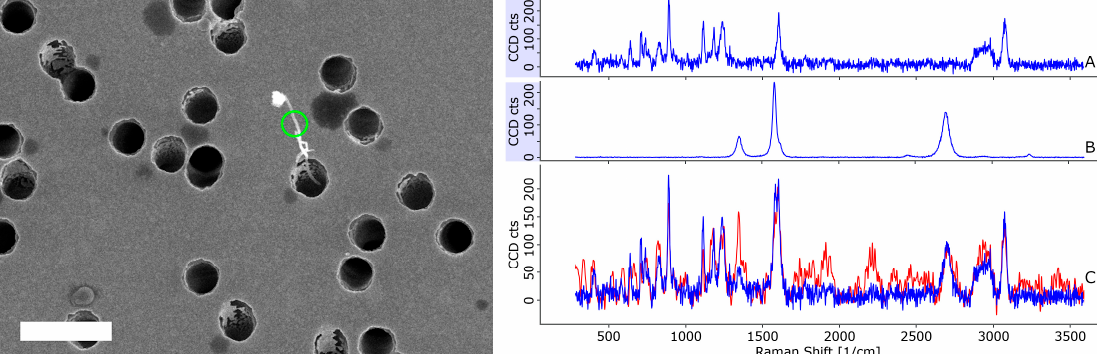
Figure 3. Raman analysis of the only MWCNT candidate fiber found at WP09. ( Left ) SEM image of the fiber with the position and lateral resolution of the Raman laser spot symbolized in green. The length of the scale bar is 1 μm . ( Right ) Raman spectra of ( A ) Polycarbonate of the filter membrane as detected through the 40 nm gold coating; ( B ) MWCNT material handled at the workplace; ( C ) red: Raman spectrum taken at the indicated position; blue: Superposition of spectrum ( A,B ) fitted to the red spectrum.